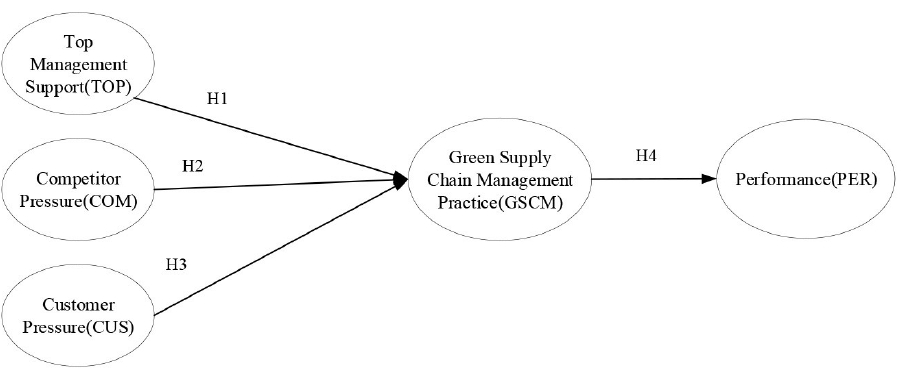
Figure 1. Conceptual